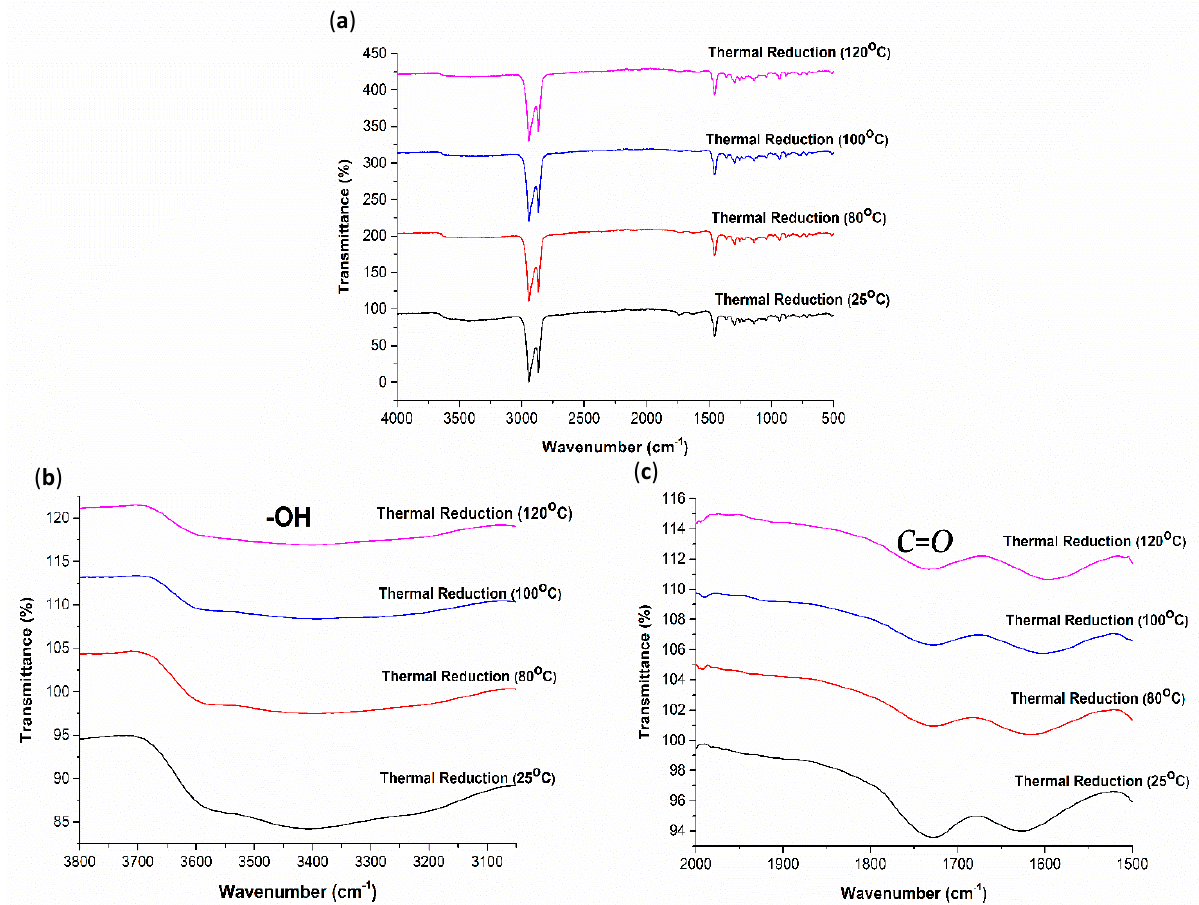
Figure 14. ( a ) FTIR − ATR spectra for 4 mg/mL GO − coated COC treated thermally for different temperatures and expanded regions of FTIR − ATR spectra between ( b ) 3050 − 3800 cm − 1 and ( c ) 1500 − 2000 cm − 1 .